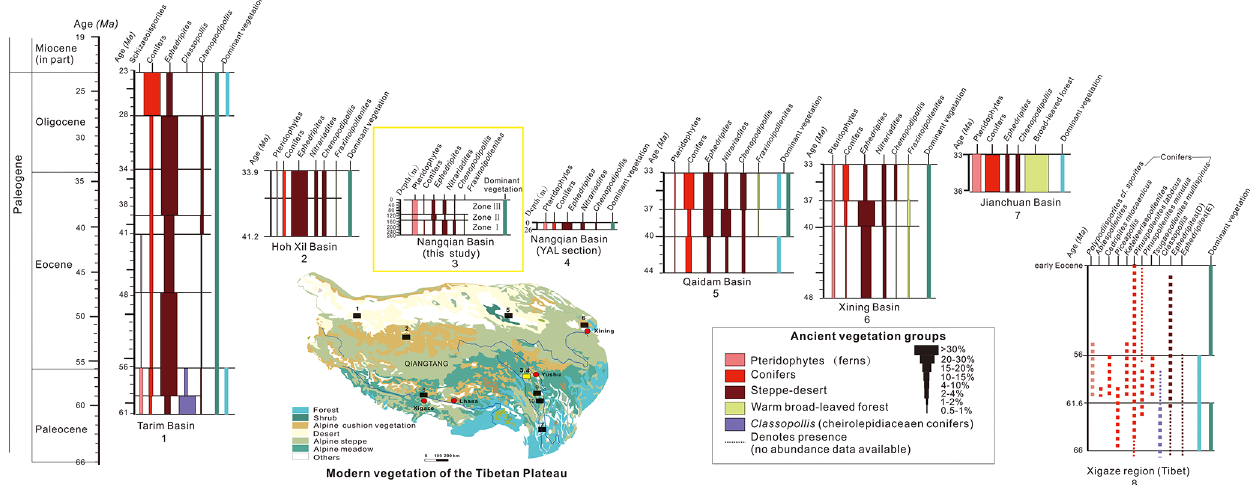
Figure 4. Palynozonation of the Paleogene successions across the northern, central, and southern Tibetan Plateau, with the numbers under each section indicating the associated basin: 1, Tarim Basin (Wang et al., 1990a, b); 2, Hoh Xil Basin (Miao et al., 2016); 3 and 4, Nangqian Basin (this study; Yuan et al., 2017); 5, Qaidam Basin (Zhu et al., 1985; Zhang, 2006; Miao et al., 2016); 6, Xining Basin (Wang et al., 1990a, b; Hoorn et al., 2012); 7, Jianchuan Basin (Wu et al., 2018); and 8, the Xigaze region (Li et al., 2008). The dominant ancient vegetation reconstructed from palynological assemblages is shown to the right of each section. The modern vegetation map was redrawn from Baumann et al.